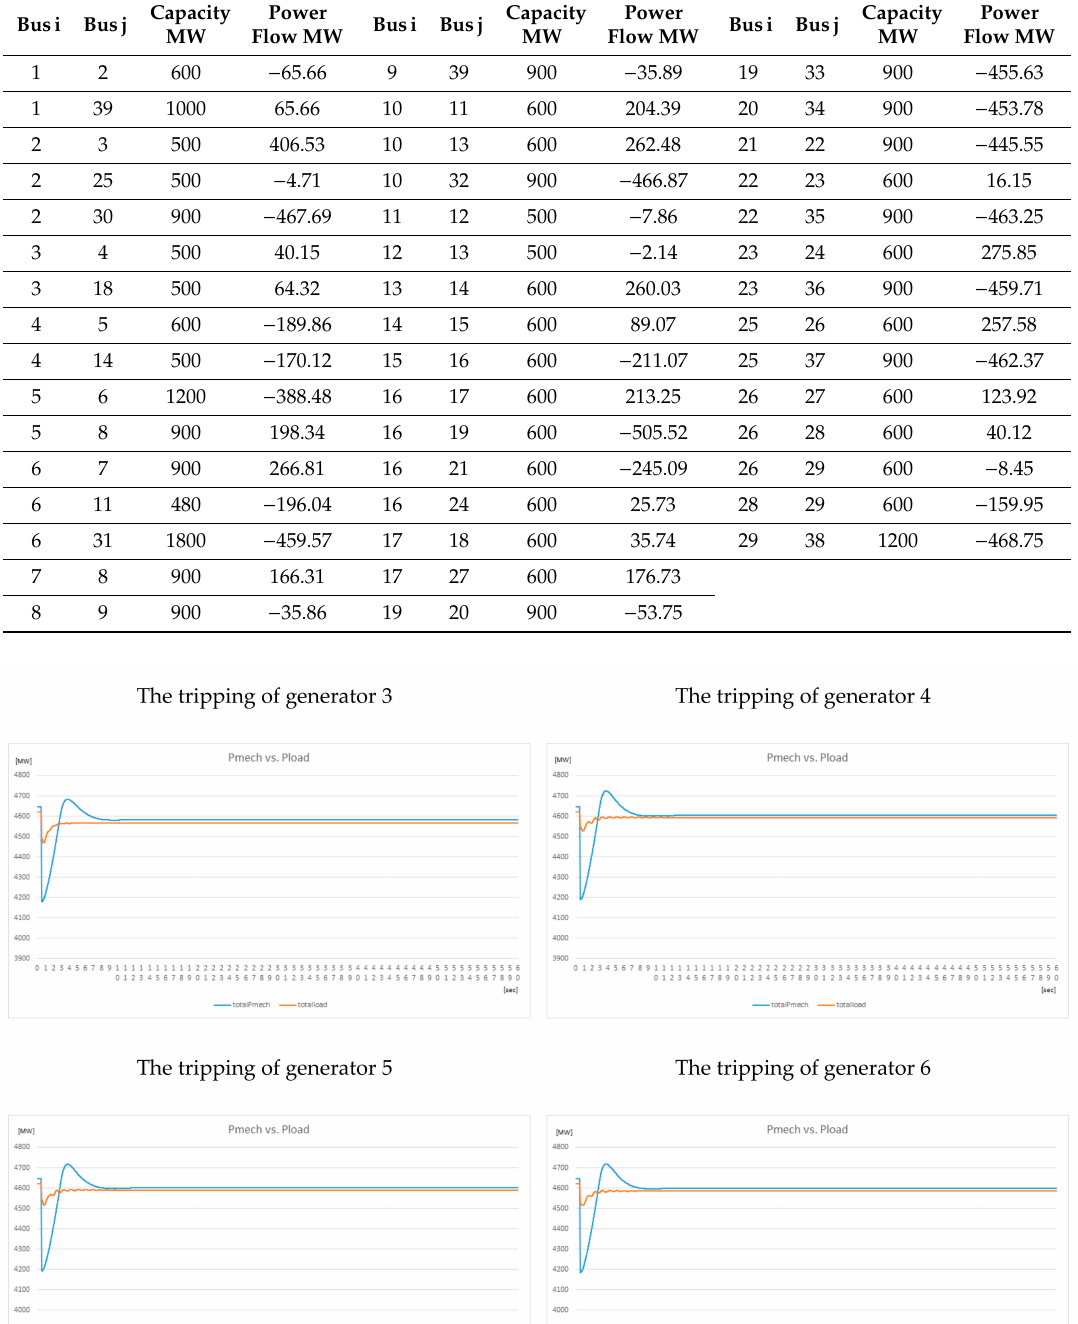
Table A2. Optimal power flow result.